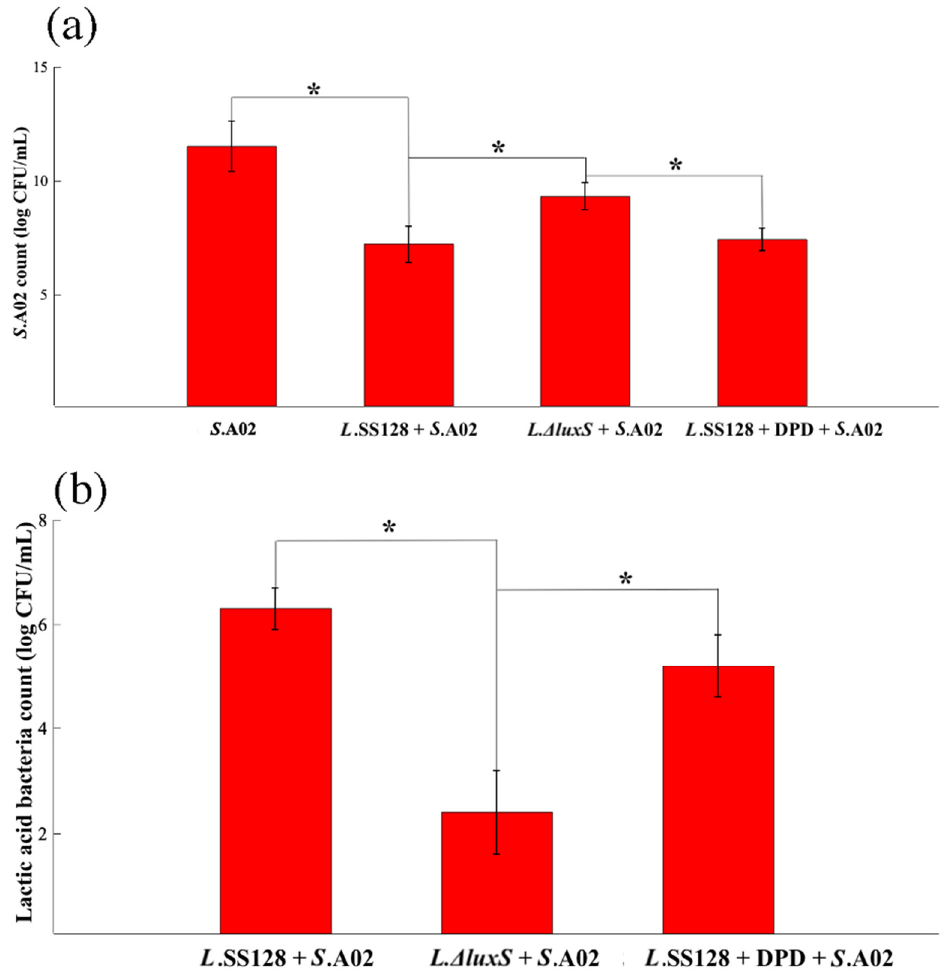
Figure 1. Bacteria count in the myofibril simulation system. ( a ) S. baltica A02 count; ( b ) lactic acid bacteria count. * Represents mean values differ significantly at p < 0.05.